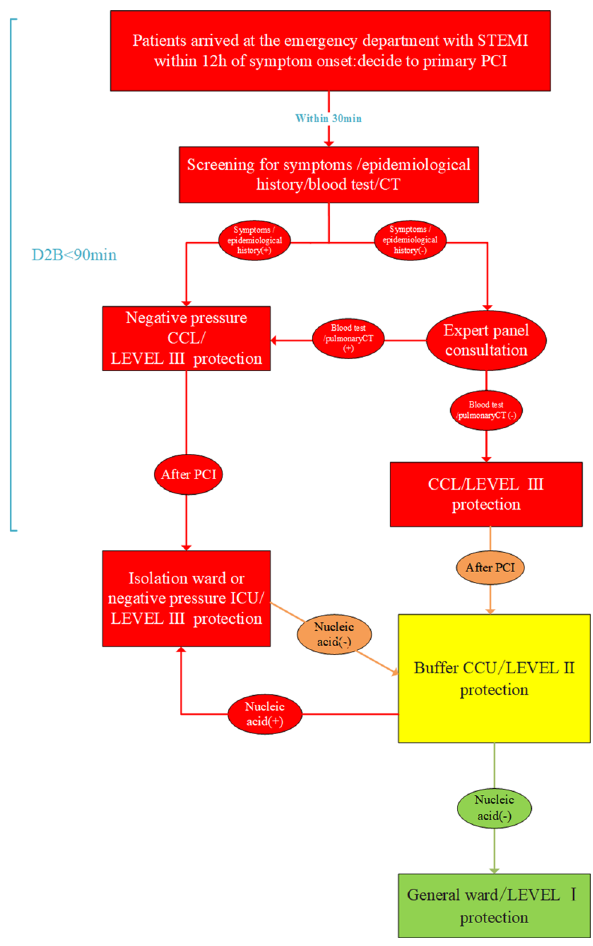
Figure 1. Safety measures and procedures for primary PCI in AMI patients in 2020 coronavirus disease (COVID-19) pandemic period at this